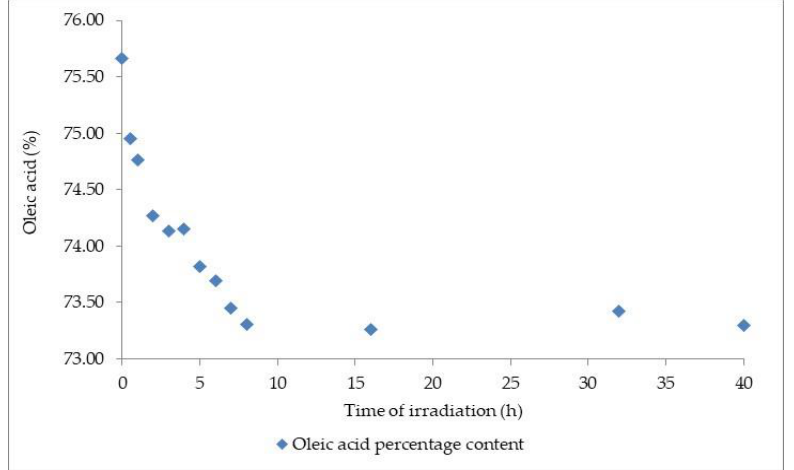
Figure 3. Percentage content of oleic acid in Cerasuola “green” (CV); sample irradiated at different time.